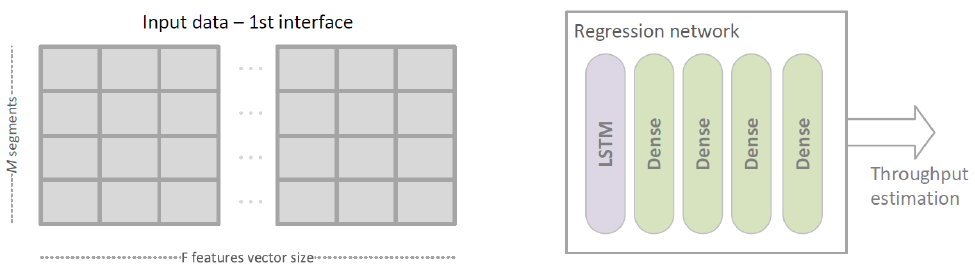
Figure 9. DLR-LEM network